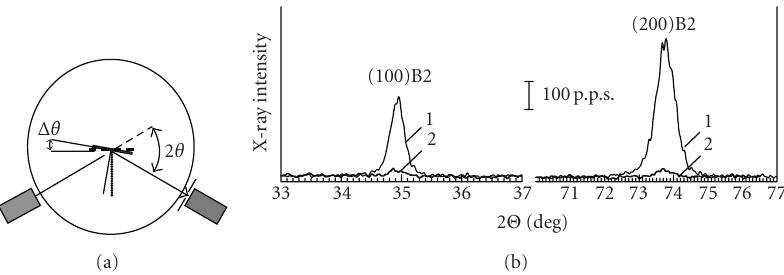
Figure 2: Misorientation of the specimen position by the angle Δ θ relative to the position in the symmetric Bragg di ff raction geometry (a), fragments of X-ray di ff raction patterns for the TiNi specimens irradiated with E 1 = 4J/cm 2 (b): Bragg di ff raction geometry (1), Bragg di ff raction geometry with misorientation of the specimen position (scheme a) by the angle Δ θ = 1 . 5 ◦ (2). Co-K α radiation, entrance and exit horizontal slits of width 0.1mm.